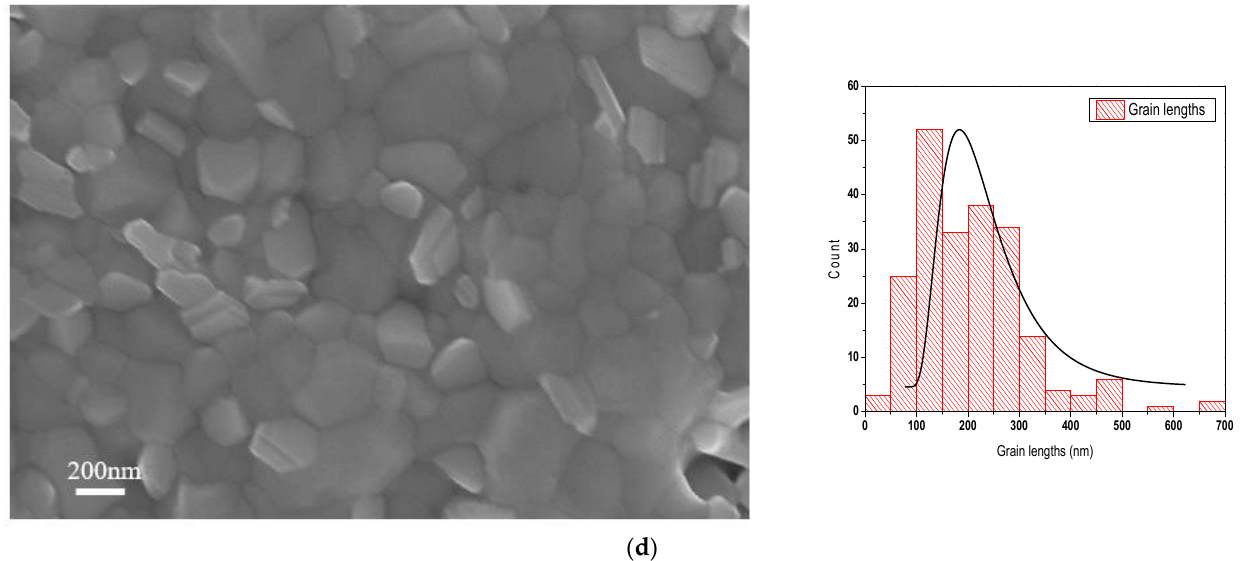
Figure 2. Left, SEM images of surface topography of the perovskite layer deposited on the ( a ) undoped M-TiO 2 and mesoporous TiO 2 doped with ( b ) FK209, ( c ) FK209/Li + and ( d ) Li + . Right, the histogram shows an average grains size for ( a ) undoped M-TiO 2 , 163.9 nm; ( b ) M-TiO 2 doped with FK209, 242 nm; ( c ) FK209/Li + , 210 nm; ( d ) Li + , 205 nm.